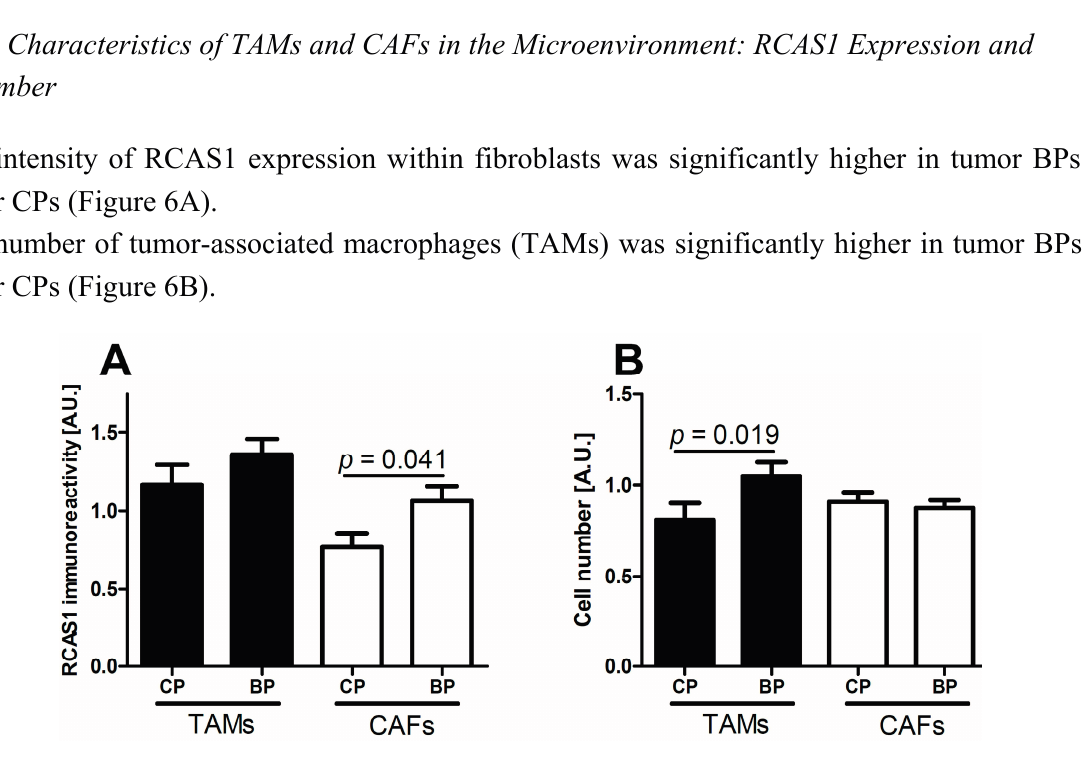
Figure 6. RCAS1 immunoreactivity ( A ) of cells in the tumor microenvironment and number of cells in the tumor microenvironment ( B ) in the central part (CP) and border part (BP) regions of tumors. TAMs: tumor-associated macrophages; CAFs: cancer-associated